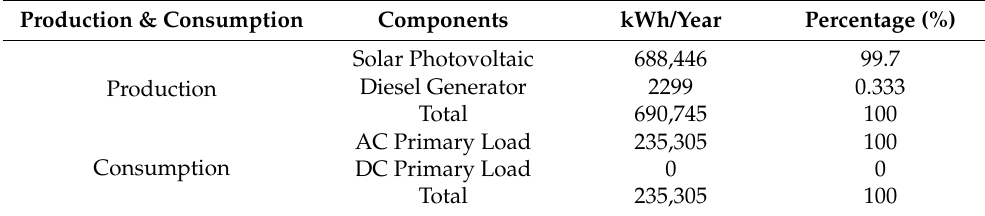
Table 5. Energy production and consumption.